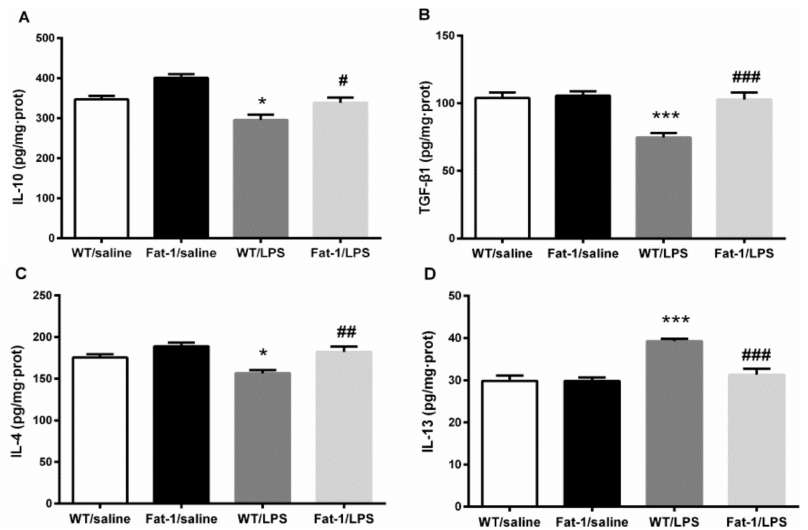
Figure 6. LPS decreased the concentration of IL-10, IL-4 and transforming growth factor (TGF)- β 1, but increased IL-13. These abnormalities were attenuated significantly in Fat-1 mice for IL-10, IL-4, TGF- β 1, and IL-13. ( A ) IL-10; ( B ) TGF- β 1; ( C ) IL-4; ( D ) IL-13. * p < 0.05, *** p < 0.001 vs. WT/saline; # p < 0.05, ## p < 0.01, ### p < 0.001 vs. WT/LPS. LPS: lipopolysaccharides; WT: